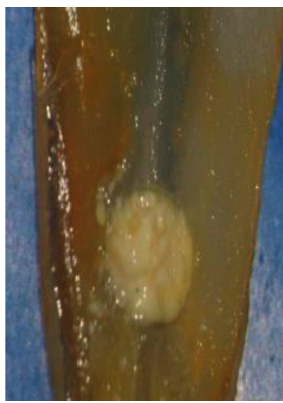
Figure 1: Score 0. The cavity is empty (e.g., in the negative control group).